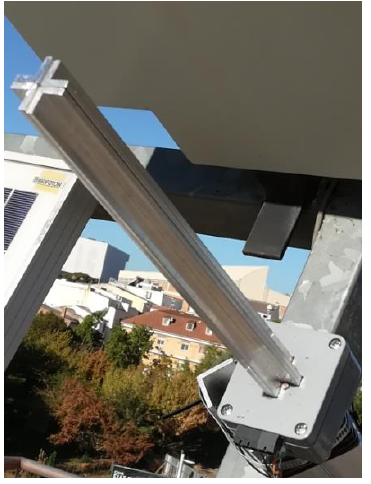
Figure 3. Pointing device. Top view.